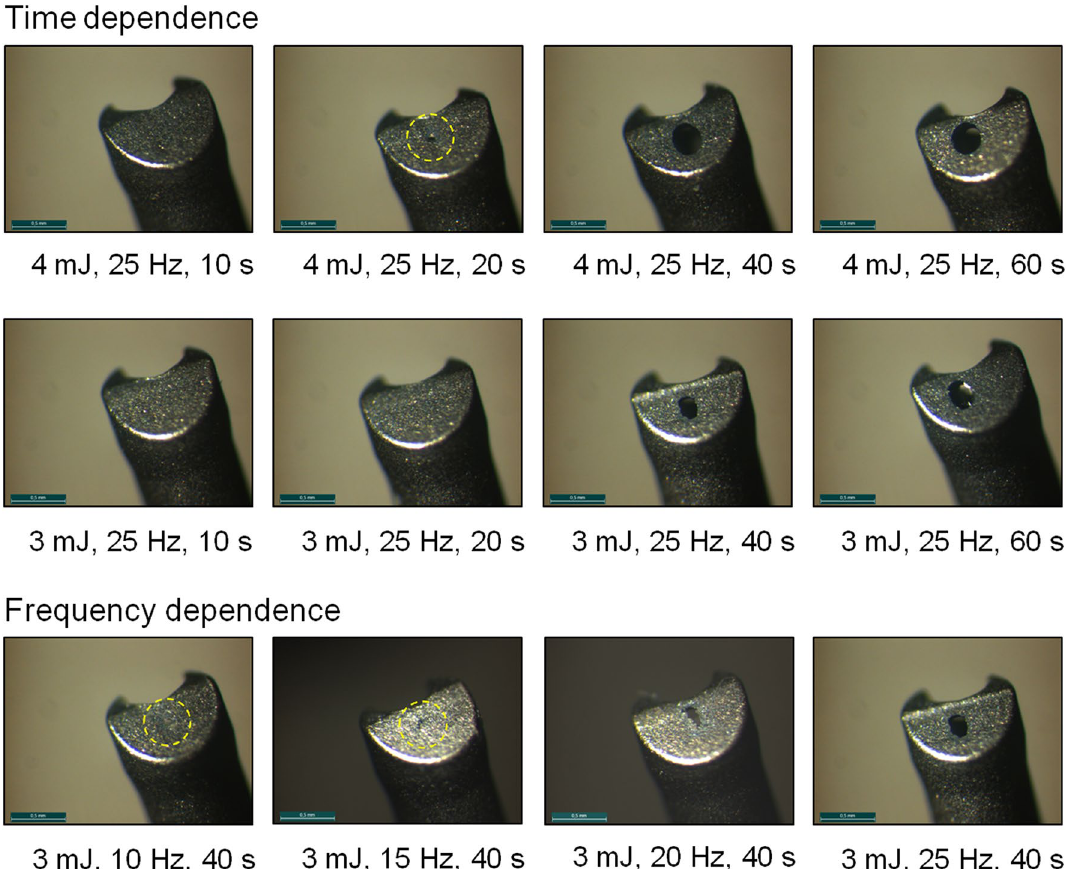
Figure 4. Absorber plates of Mark I handpieces in time-dependence [3 mJ and 4 mJ at 1500 cuts/min (25 Hz)] and frequency-dependence [3 mJ and 40 s in a range of 600–1500 cuts/min (10–25 Hz)]. The interaction between the absorber plate and laser radiation (plasma formation) is needed for vitreous body cutting to ensure aspiration. The destruction of the absorber plates affected the cutting process, resulting in a reduced slope of the curve at ≥ 600 cuts/min (10 Hz) and therefore in a reduction of the aspiration rate (Fig.